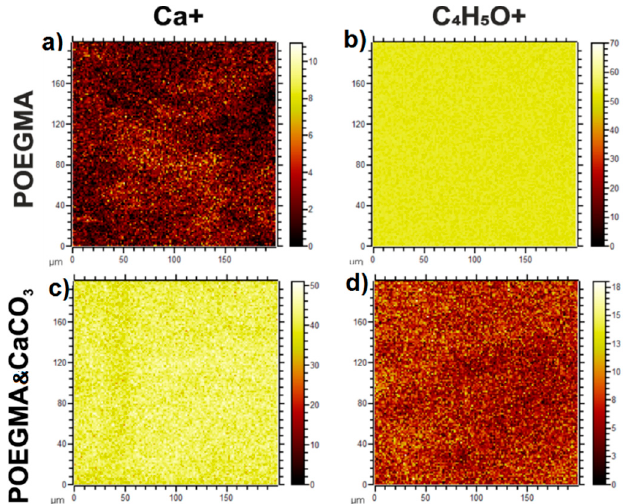
Figure 2. ToF-SIMS chemical imaging of the POEGMA-grafted brush coatings before ( a , b ) and after ( c , d ) mineralization.